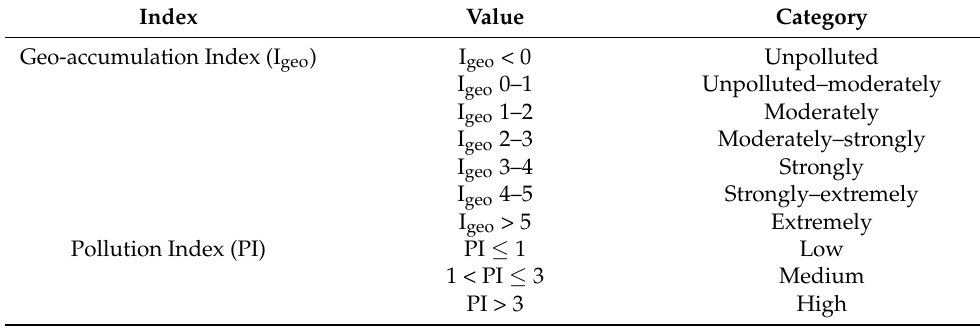
Table 1. Indexes classification for Geoaccumulation Index (I geo) and Pollution Index